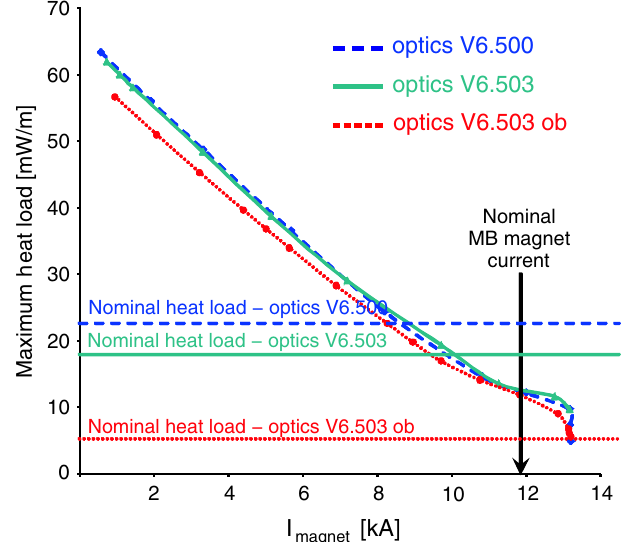
FIG. 12. (Color) Maximum allowed heat load in a single strand versus current of the MB dipole magnet for three different spatial heat load distributions caused by BFPP in different versions of the LHC optics: V6.500, V6.503 (current), and V6.503 ob (with an orbit bump as discussed in Sec. IX). The horizontal lines show the heat loads expected at design luminosity as calculated by FLUKA . The required current for 2 : 76 TeV = nucleon 208 Pb 82 þ operation is indicated by a vertical black arrow. At the arrow, the tolerated power is smaller than the expected for V6.500 and V6.503, meaning that quenches can be expected during nominal